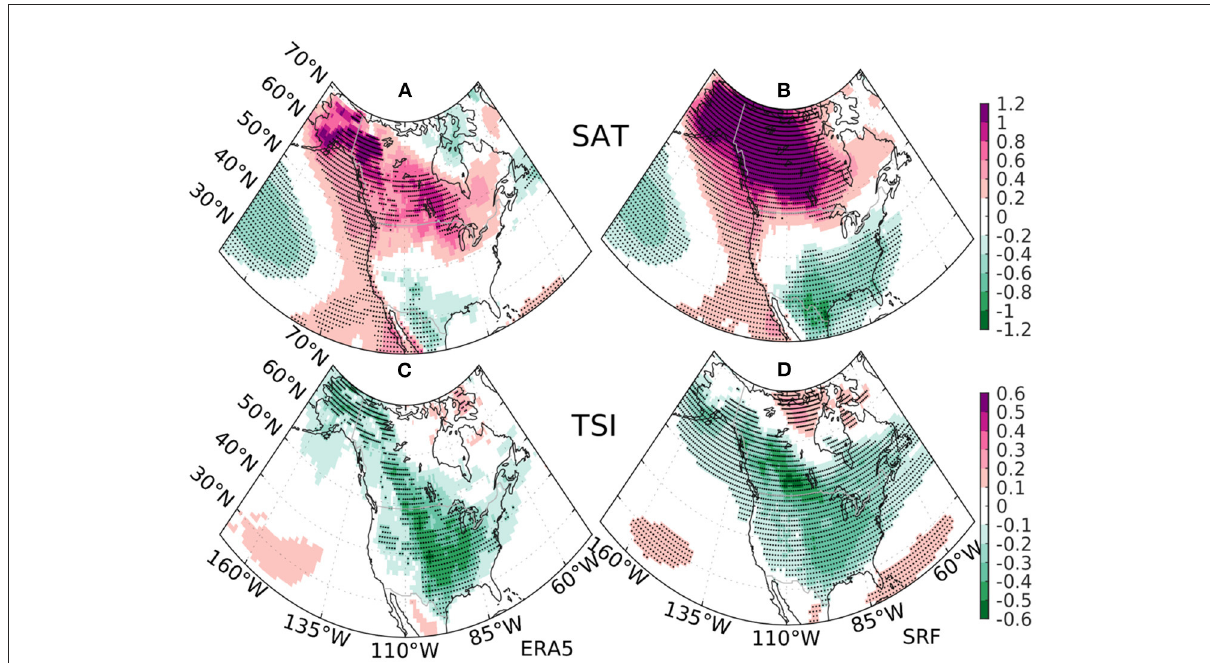
FIGURE5 The regression pattern onto the observed normalized NINO34 index for the DJF surface air temperature (SAT) (units in K) from (A) ERA5 reanalysis and (B) the ensemble mean estimates from SPEAR’s SRF during 1992–2022. The same regression pattern for the DJF Temperature Swing Index (TSI) (units in K) from (C) ERA5 reanalysis and (D) the ensemble mean estimates from SPEAR’s SRF. The stippling indicates regression coefficients significant at 10%